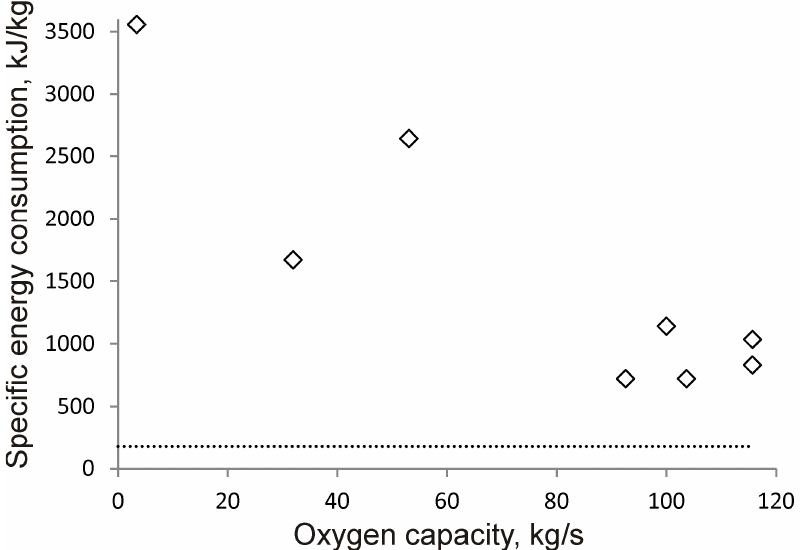
Figure 2. Dependence of the unit cost of oxygen production on plant capacity (the dotted line is the thermodynamic estimate of the minimum energy of air separation).